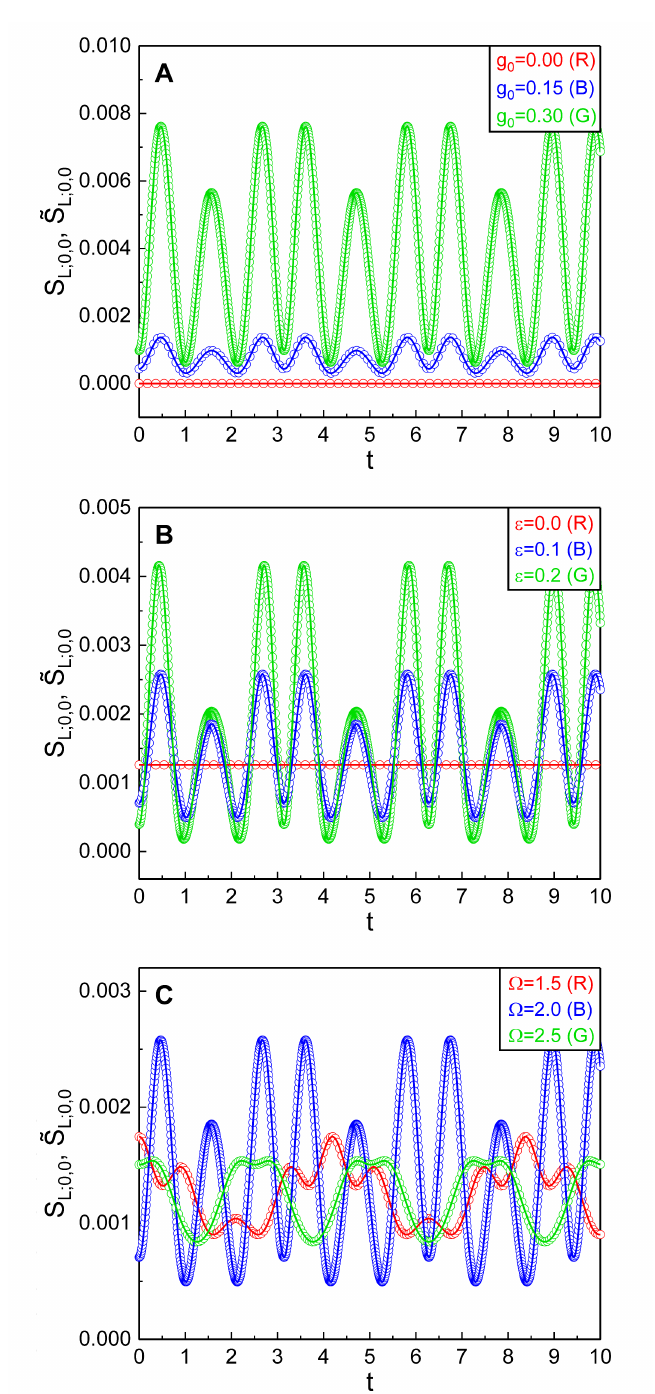
( t ) (solid lines) and ˜ S ( t ) Figure 2: Temporal evolution of linear entropies S L ;0,0 L ;0,0 (circles) for several different values of g (A), (cid:34) (B), and Ω (C). The legend of (A) 0 = 0.00 for red curves, g = 0.15 for blue curves, and g = 0.30 for means that g 0 0 0 green curves. The legends of other panels are also interpreted in this way. We used ( (cid:34) , Ω ) = (0.1, 2) for (A), ( g , Ω ) = (0.2, 2) for (B), and ( g , (cid:34) ) = (0.2, 0.1) for (C). All 0 0 = 1, ¯ ω = 3, and ν ≡ ¯ (cid:34)/(cid:34) = other values are common and given by ω m,0 c,0